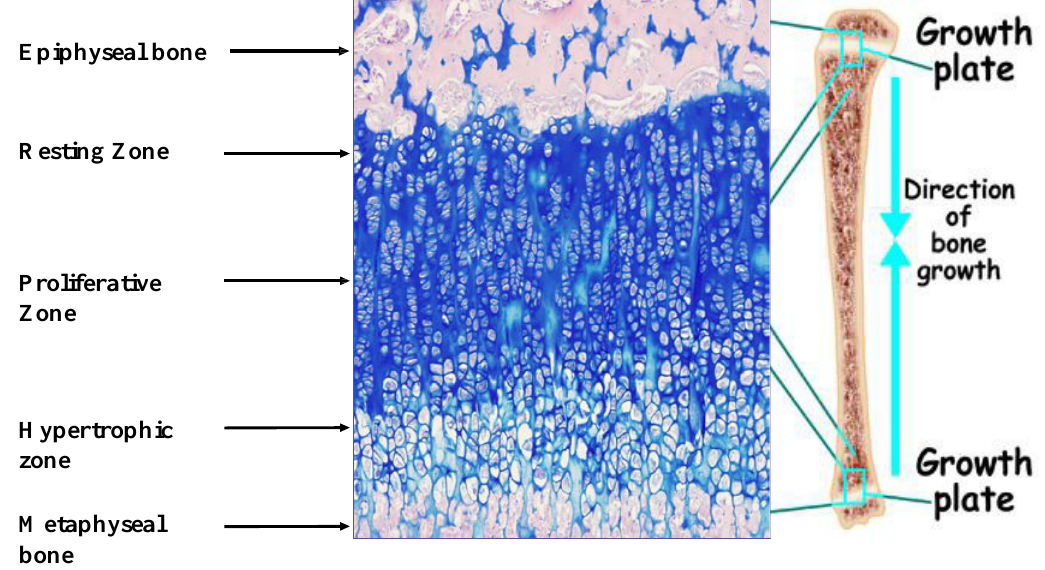
Figure 1. Epiphyseal growth plate of male Sprague Dawley rat (34 days old) stained with hematoxylin/eosine/Alcian Blue. Magnification, 100×. The different zones of the growth plate are